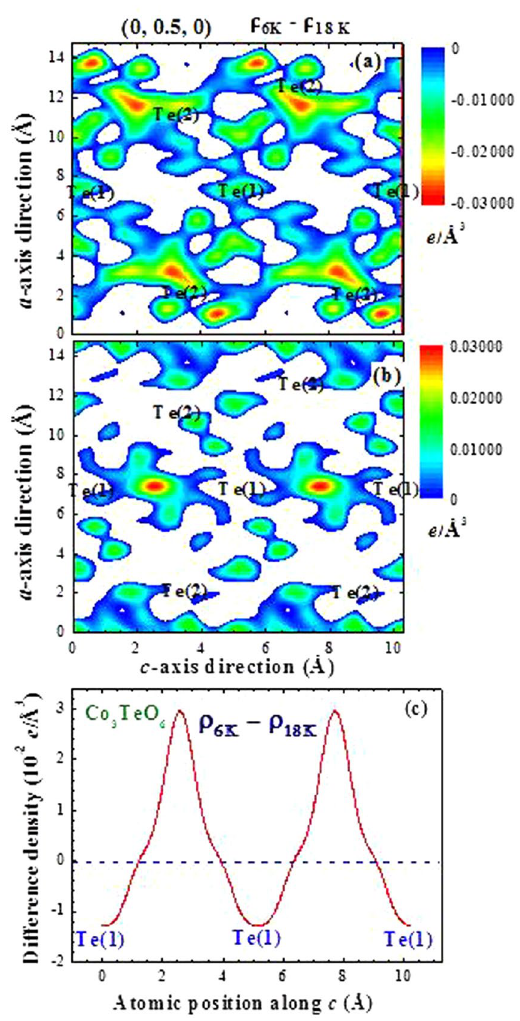
Figure 15. Portions of the difference electronic charge density maps in the y = 0.5 crystallographic plane, where ( a ) the electronic charge densities increase and ( b ) the electronic charge decrease, on cooling from 18 to 6 K. The color bars are in units of e /Å 3 . ( c ) Changes of the electronic charge density along the [001] crystallographic direction in the (0 0.5 0.835) plane upon cooling from 18 to 6